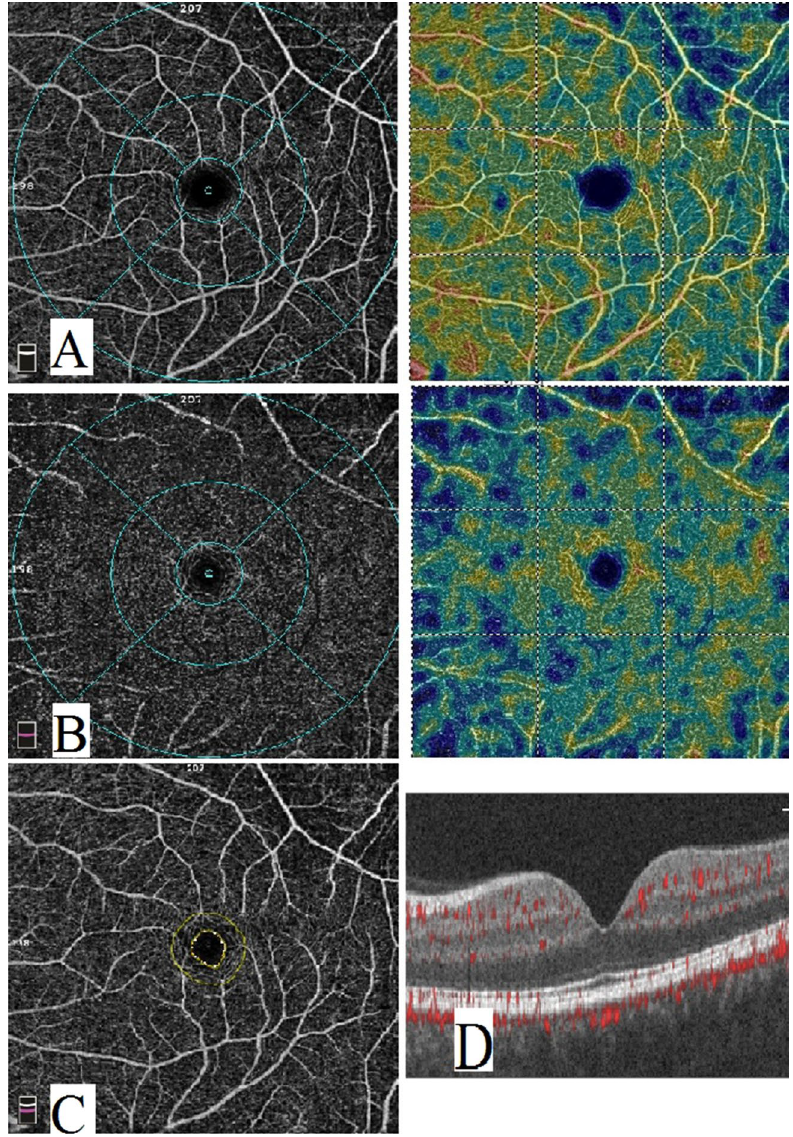
Figure 3. Optical coherence tomography angiography image of a psoriasis patient with metabolic syndrome. ( A ) enface image at the level of SCP. ( B ) enface image at the level of DCP. ( C ) FAZ. ( D ) B scan image showing blood flow at the level of SCP, DCP and